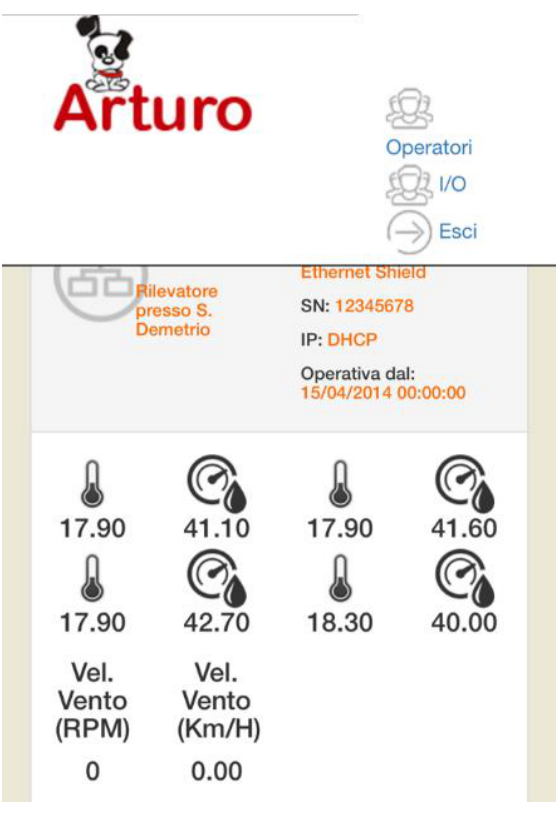
Figure 9. The software Arturo developed by DISIM, to collect the data monitored. The data were analyzed starting from the results of the previous research phase in which it was proved that the operation of the ventilation device increases its performance when there is a large difference in temperature between the external and internal air. This was positive in the months of July, August and September, the months also monitored for air quality. In fact, natural internal ventilation brings benefits to air quality if the air introduced is not polluted. The purpose of the following analyses was to correlate the internal temperature with the air quality in order to also verify the correct operation of the device in this aspect. It was verified through monitoring that the daily temperatures follow the trend of the temperate climate with strong nocturnal variations compared to the daytime (Table 1). Therefore, in the graphs, the averages of the daytime hours were considered. Table 1. Air quality monitoring data.